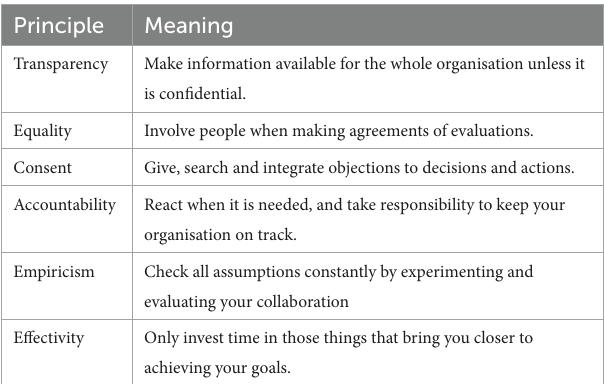
TABLE 11 Basic principles of Sociocracy 3.0, adapted based on data from our research. Principle